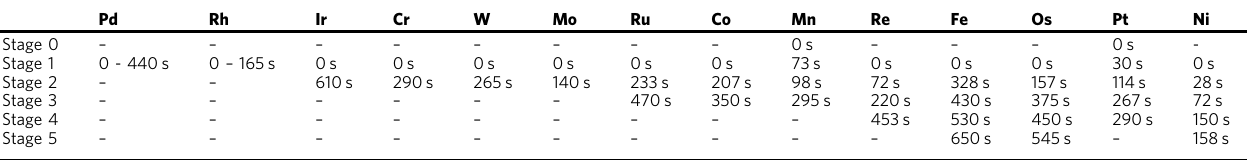
Table 2 Activity of metal towards defect formation in nanotube sidewall